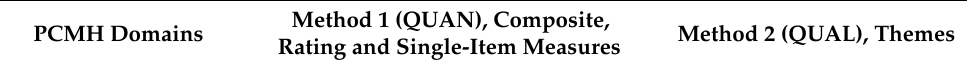
Table 4. Matrixed Data